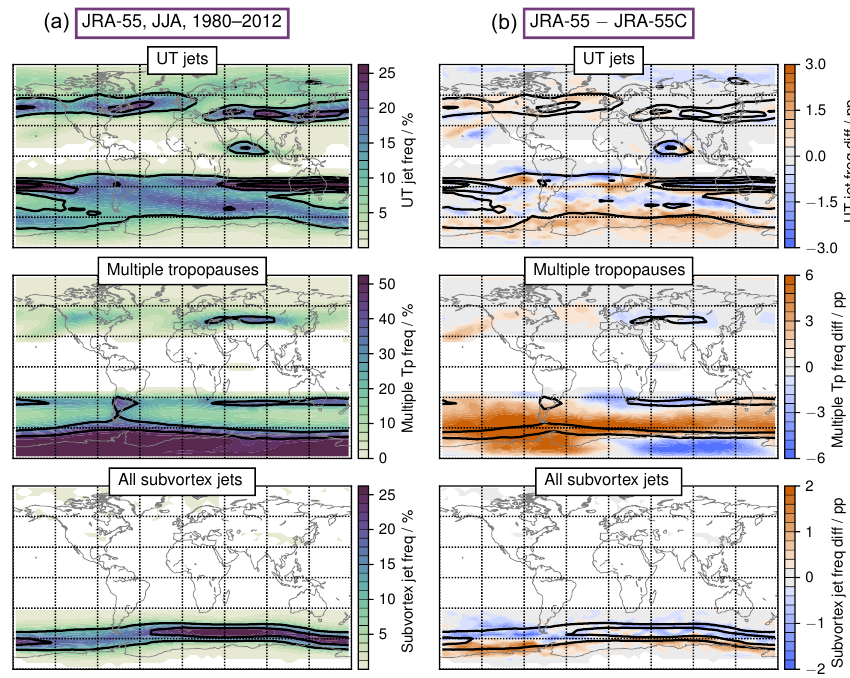
Figure 5. Seasonal maps of frequency distributions during JJA in 1980 through 2012 of JRA-55 (a) fields and the difference between JRA-55 and JRA-55C fields (b) . Layout is as in Fig.